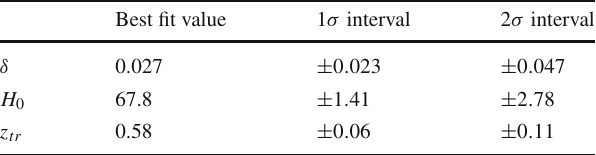
Table 2 Best fit values of the model parameters δ , H 0 and z tr together with their 1 σ and 2 σ confidence intervals for the logarithmic model